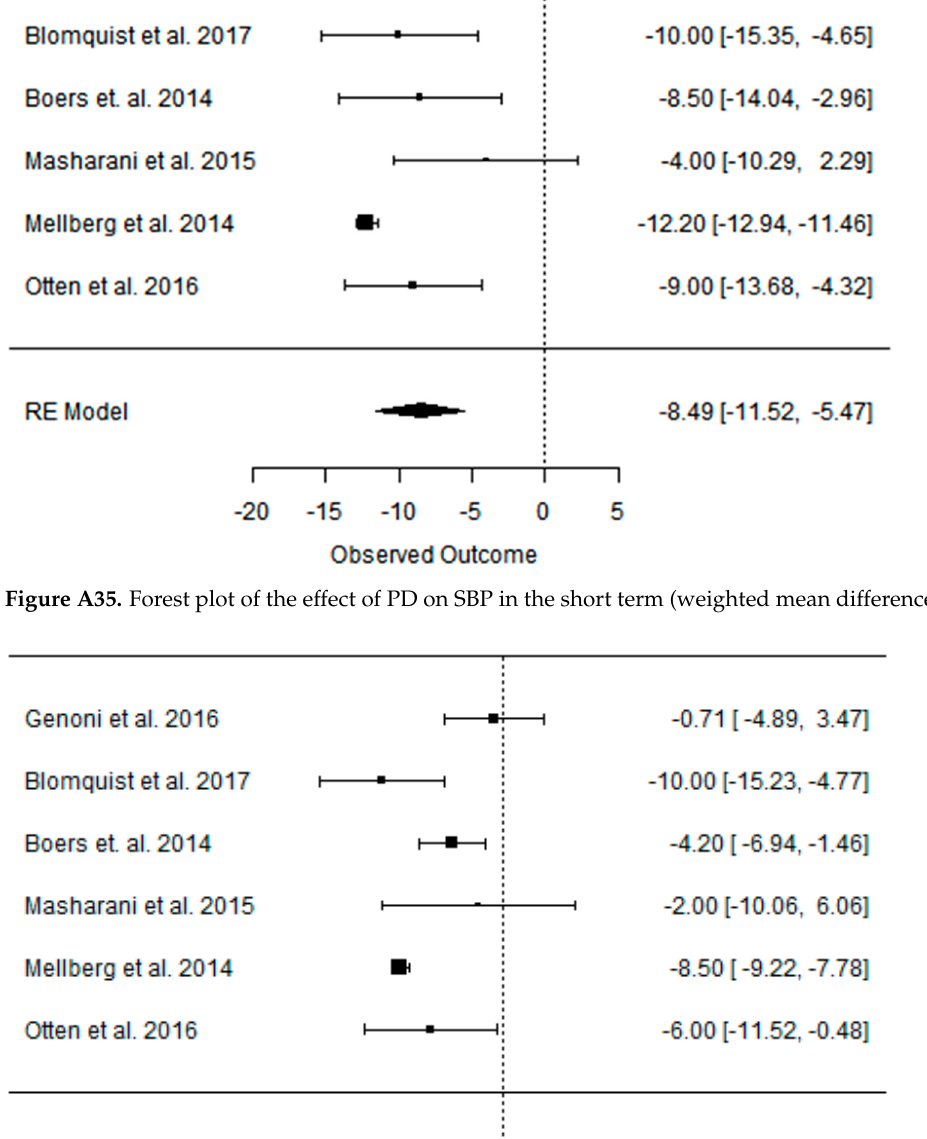
Figure A34. Forest plot of the effect of a PDs on SBP in the short term (weighted mean difference).